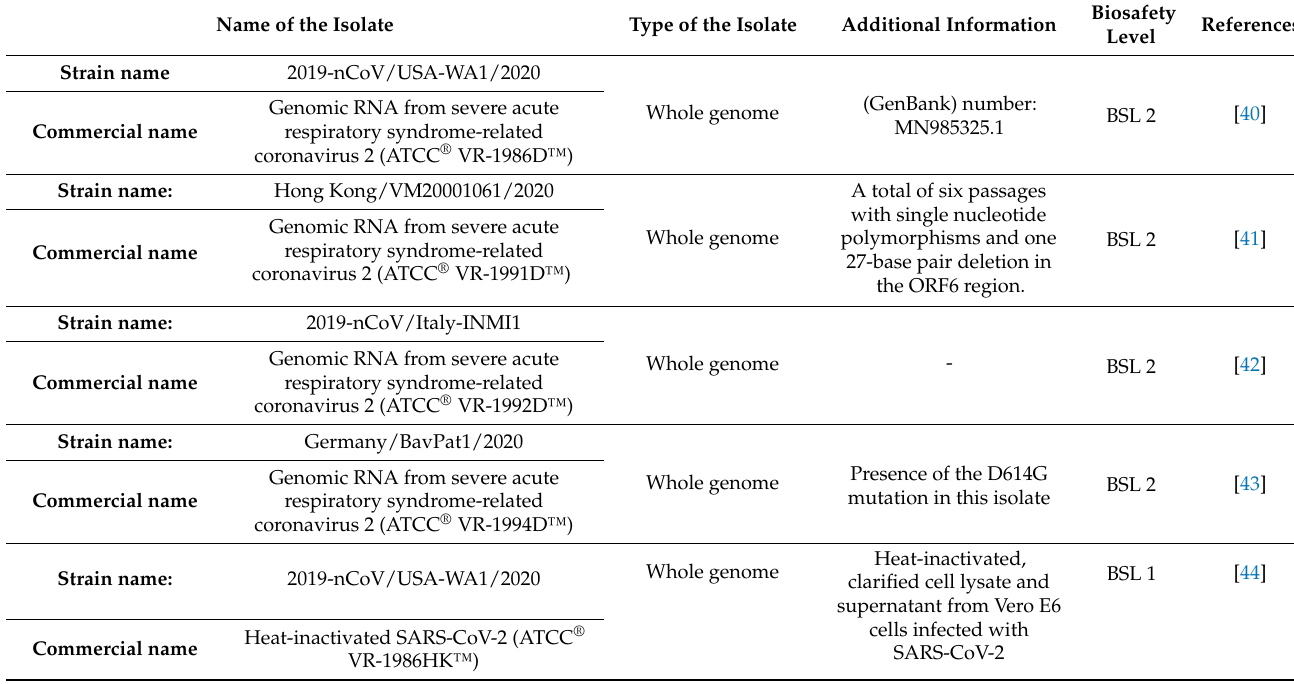
Table 1. Genome isolates, and gene fragments of SARS-CoV-2 available from the American Type Culture Collection (ATCC). Name of the